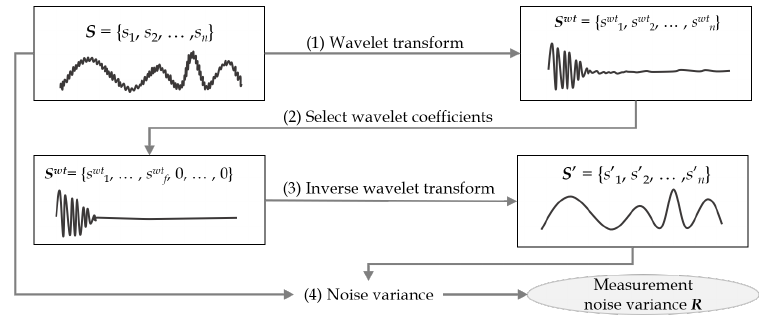
Figure 4. Measurement noise variance estimation using a wavelet transform.